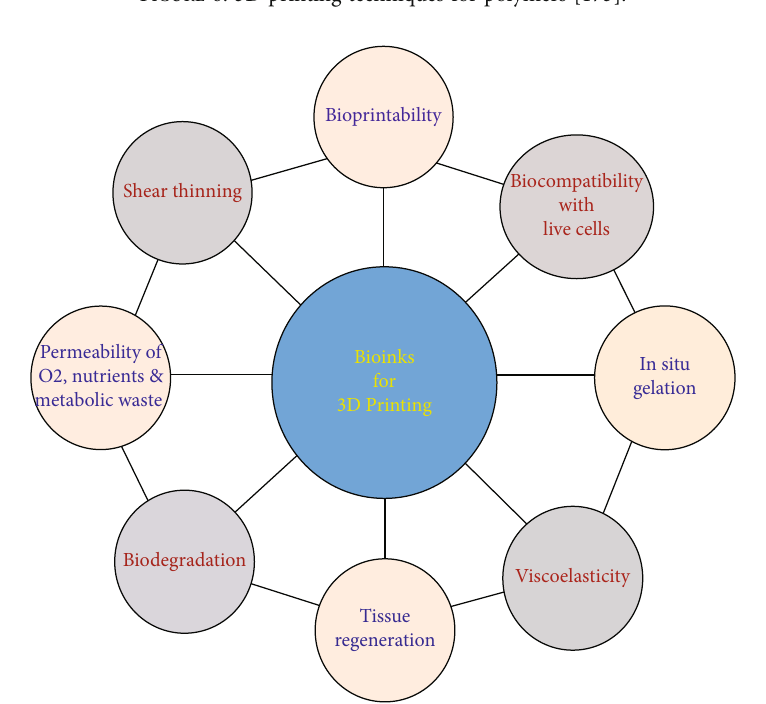
Figure 7: Bioink for 3D printing in biomaterial features